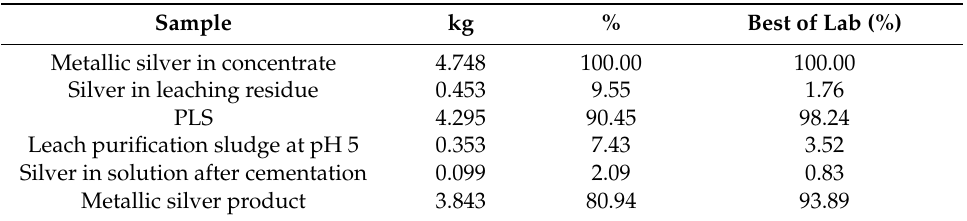
Table 8. Silver recovery of the upscaling process